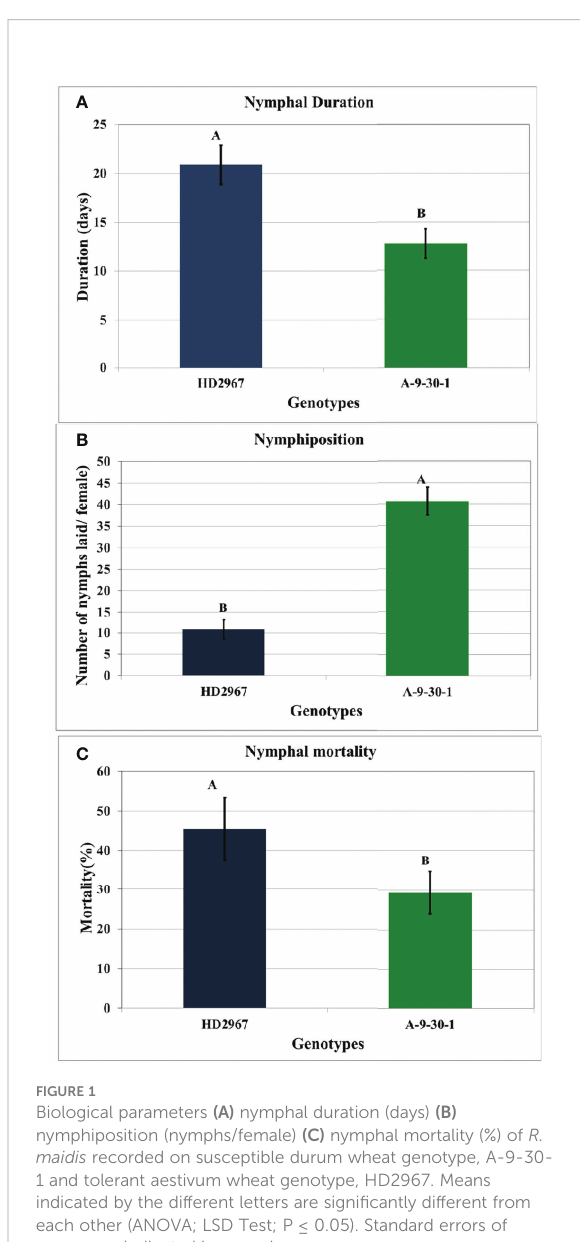
FIGURE 1 Biological parameters (A) nymphal duration (days) (B) nymphiposition (nymphs/female) (C) nymphal mortality (%) of R. maidis recorded on susceptible durum wheat genotype, A-9-30- 1 and tolerant aestivum wheat genotype, HD2967. Means indicated by the different letters are signi fi cantly different from each other (ANOVA; LSD Test; P ≤ 0.05). Standard errors of means are indicated by error bars.